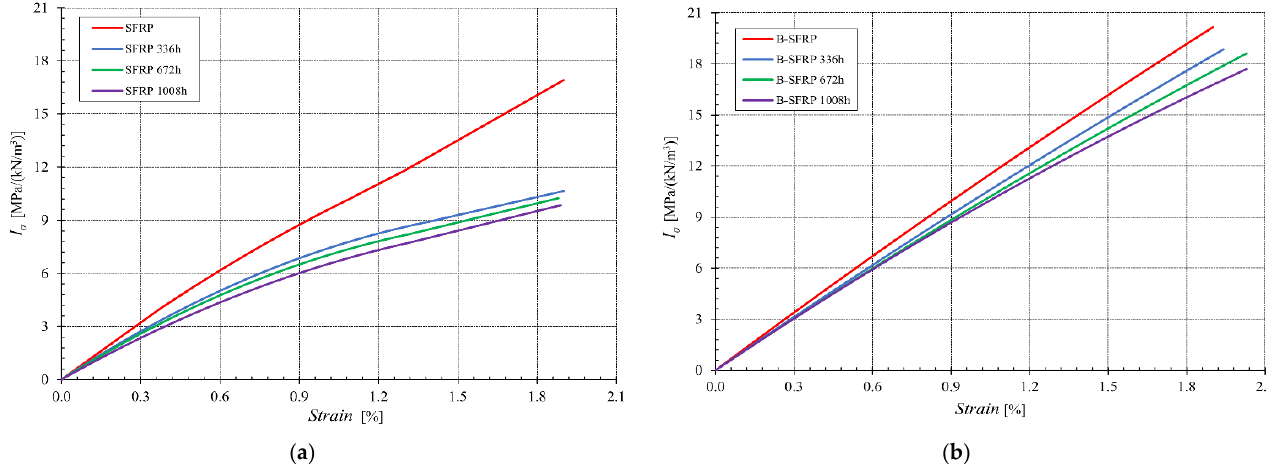
Figure 9. Tensile curves of ( a ) SFRP and ( b ) B-SFRP biocomposites before and after progressive aging.